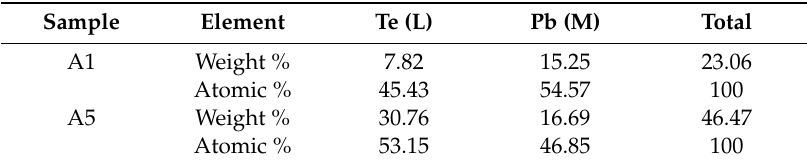
Table 2. Elemental content of samples A1 and A5.